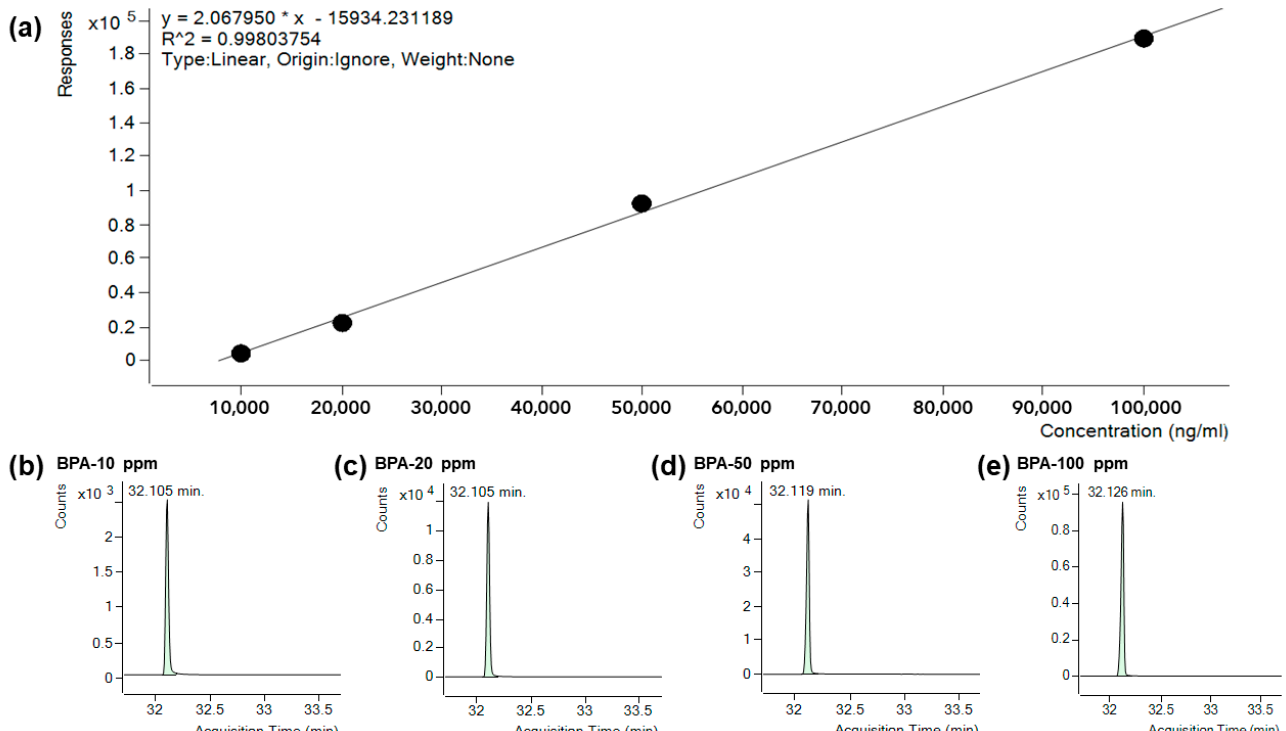
Figure 1. Calibration after GC-MS measurement of the standard samples: ( a ) Linear calibration of 4 samples, ( b ) Selected Ion (213.3) bisphenol A 10 ppm, ( c ) Selected Ion (213.3) bisphenol A 20 ppm, ( d ) Selected Ion (213.3) bisphenol A 50 ppm, ( e ) Selected Ion (213.3) bisphenol A 100 ppm.